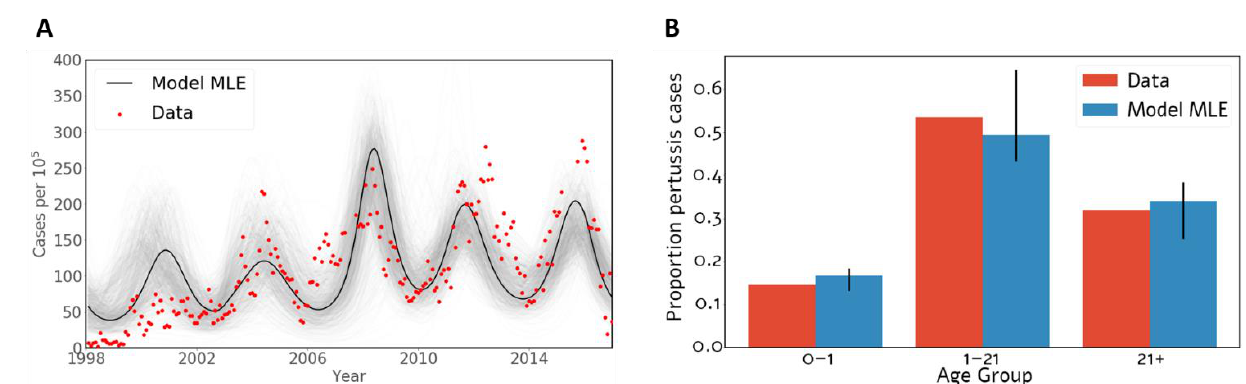
Figure 2. Fit of the model. ( A ) Time series of recorded monthly pertussis cases and model fit, with the solid line representing the maximum likelihood. ( B ) Data and model fit to the age distribution among pertussis infections.